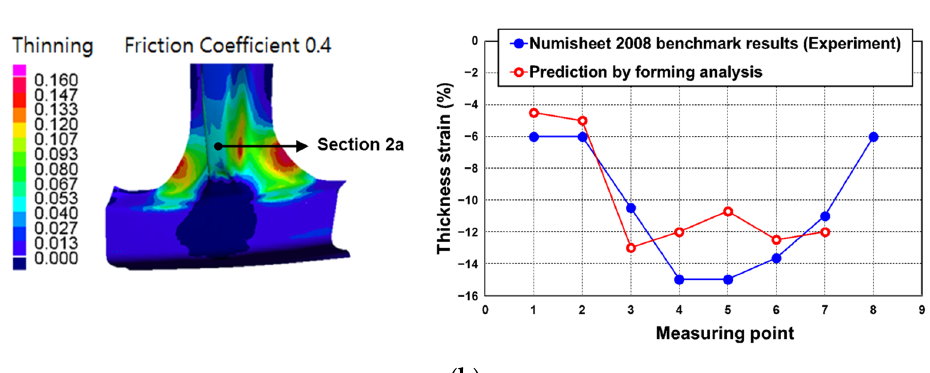
Figure 11. Reference positions for comparing ( a ) thickness strain and ( b ) martensitic phase ratio in B ‐ pillar parts .